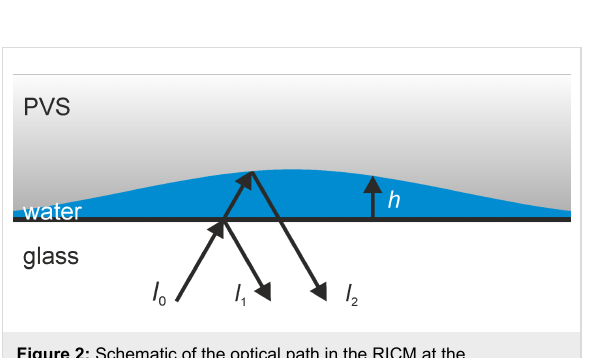
Figure 2: Schematic of the optical path in the RICM at the glass–water–PVS layers. The incoming beam with intensity I 0 is partially reflected at the glass-water interface ( I 1 ) and at the water–PVS interface ( I 2 ). The optical path difference between I 1 and I 2 depends on the distance h between glass and PVS, the angle of inci- dence, and on the refractive index of